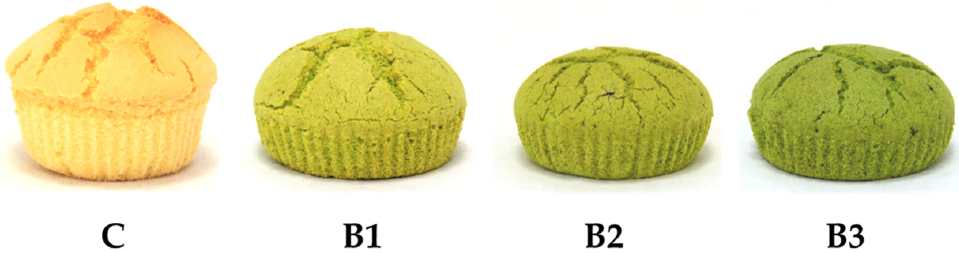
Figure 1. The presentation of the experimental pasta fortified with BLP. C—control, B1—2.5% starch replacement with BLP, B2—5% starch replacement with BLP, and B3—7.5% starch replacement with BLP.